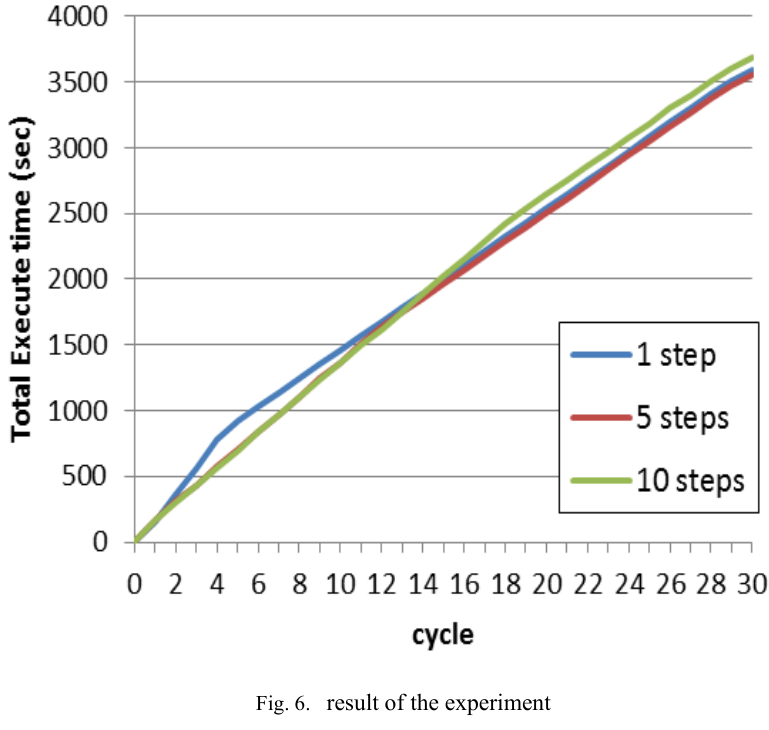
Fig. 6. result of the experiment